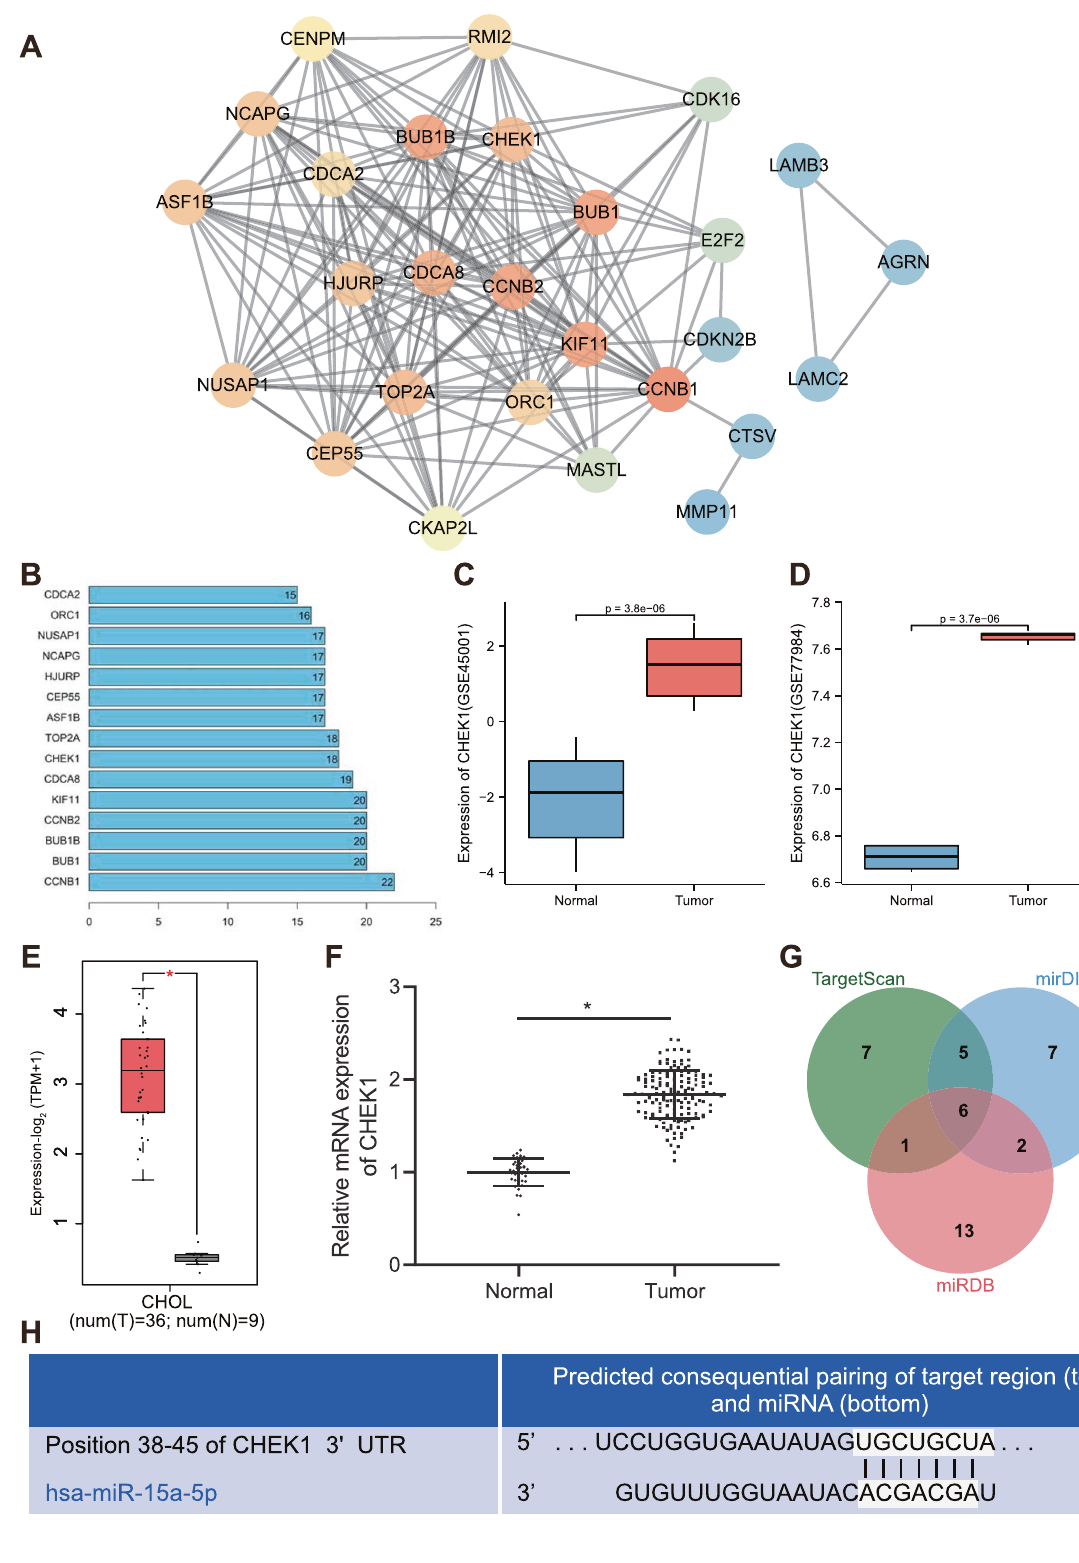
(Fig. 1B). These 14 genes were further screened in GSE26566 microarray data. As displayed in Table S1, CHEK1 was the most signi fi cant upregulated gene. A published research has shown that CHEK1 is an important factor related to DNA replication and cell survival in cancer cells [21], and executes the function of the Cell Death Discovery (2022)